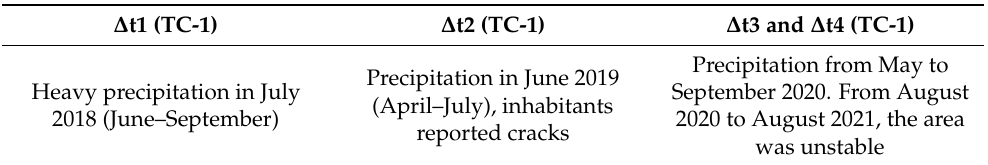
Table 2. Time increments related to cumulative precipitation, borehole inclinometer, and InSAR mean downslope displacement data from June 2018 to August 2021 in the eastern channel of the Kawai landslide (TC-1 area).